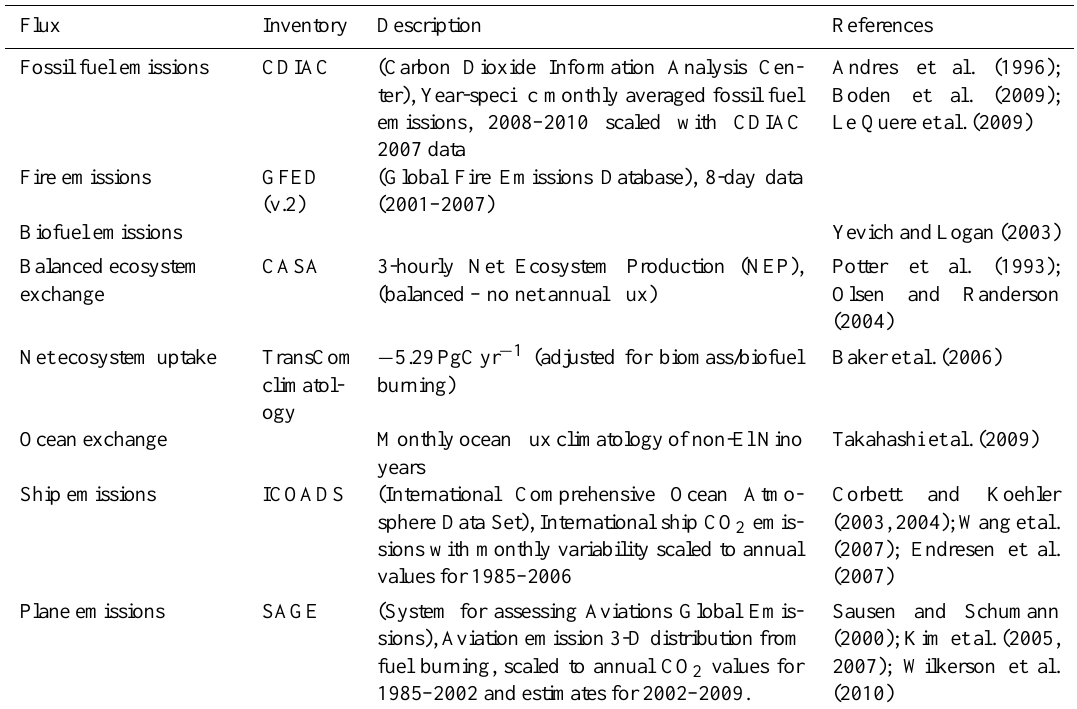
Table 1. Fluxes used in the GEOS-Chem CO 2 simulation. The inventories, a short description and references are listed as in Nassar et al.